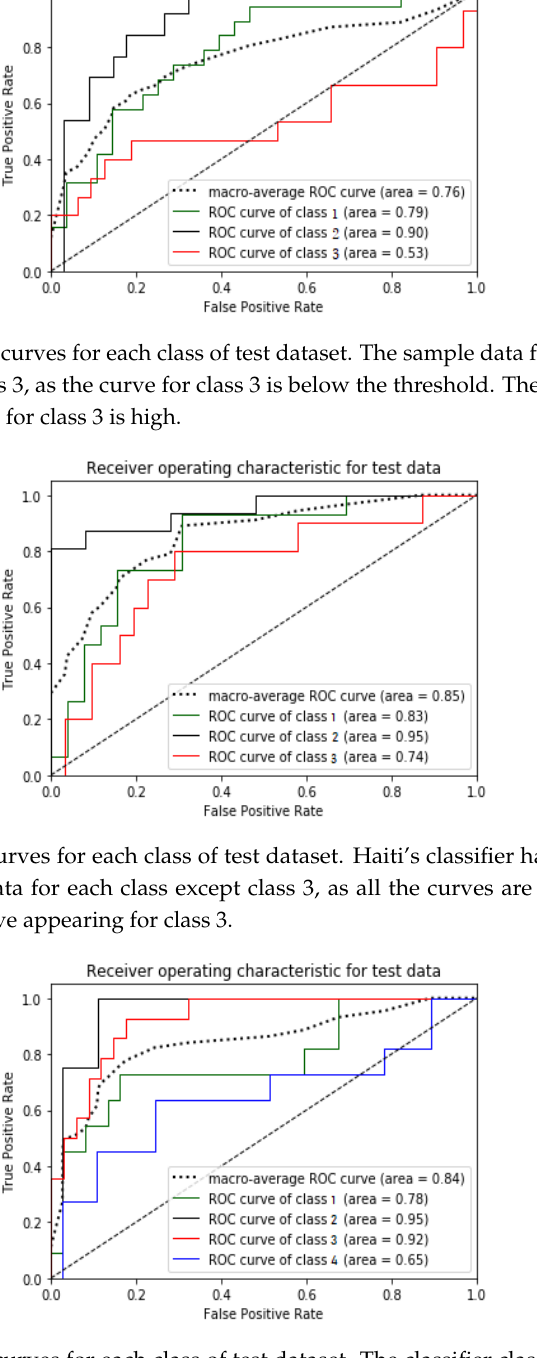
Figure 11. Nepal—ROC curves for each class of test dataset. The classifier classified classes 2 and 3 better than classes 1 and 4 samples. A higher false-positive rate appeared for class